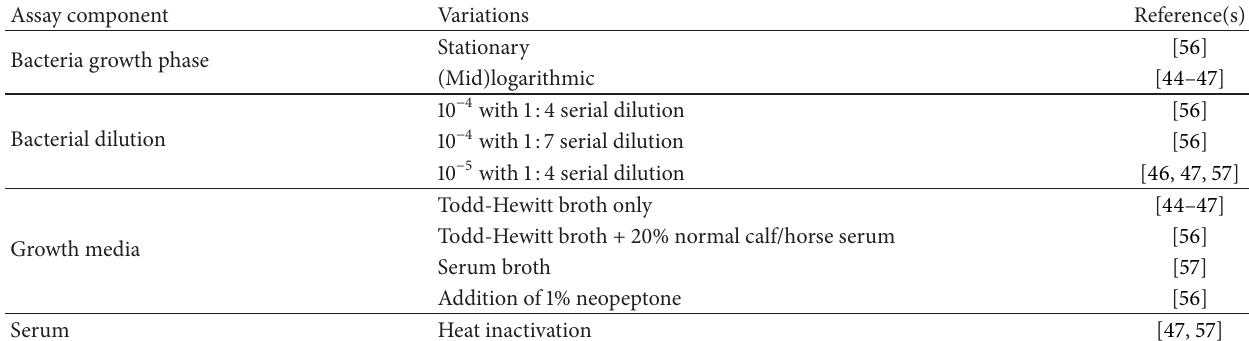
Table 2: Variations across methods used in performing the indirect bactericidal